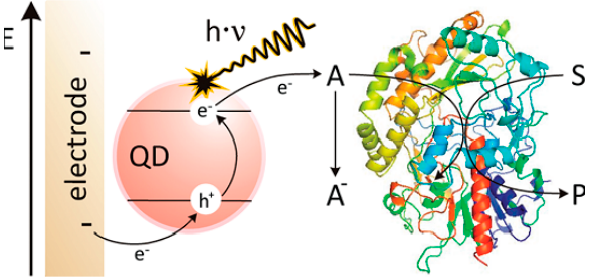
Figure 2. Illustration of the electron transfer steps after illumination of the QD electrode. Reprinted with permission from [40].